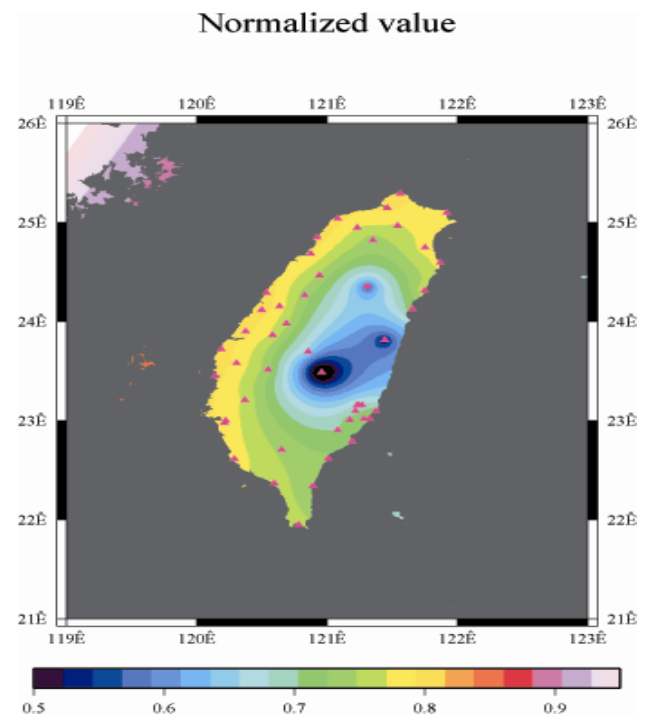
Figure 9. Normalized ZTD values around the island before the typhoon struck Taiwan (September 13th, 2008, 3:00 PM).